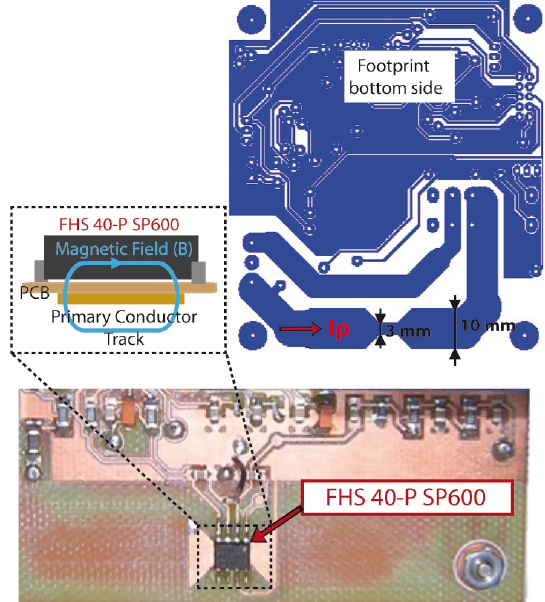
Figure 3. Principles of current measurement using FHS-40P/SP600 current